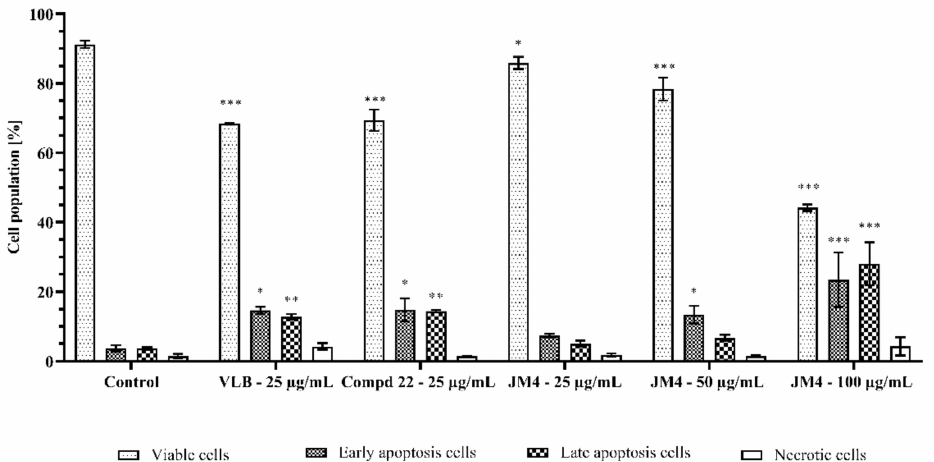
Figure 6. Percentage of viable C32 melanoma cells, early and late apoptosis cells, and necrotic cells, after 24 h of incubation with JM4 (25, 50, 100 µ g/mL), 22 (25 µ g/mL) and vinblastine sulfate (VLB) (25 µ g/mL). Mean percentages from three independent experiments ( n = 3) done in duplicate are presented. * p < 0.05 versus control group, ** p < 0.01 versus control group, *** p < 0.001 versus control